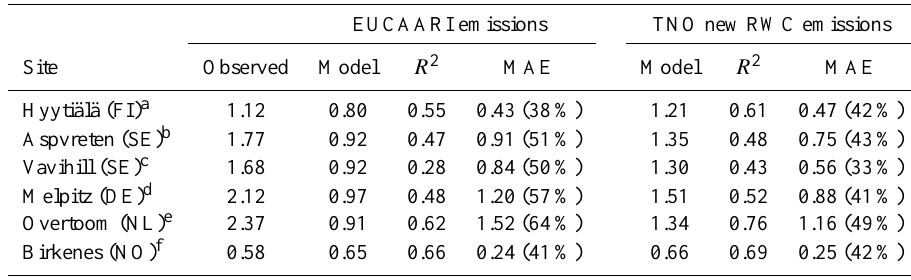
Figure 8. Comparison of predicted (PMCAMx) vs. observed (AMS) PM 1 OA (µgm − 3 ) from seven measurement sites during the EUCAARI winter 2009 campaign (25 February–23 March). Each point is a daily average value. The dashed lines represent 2:1 and 1:2 lines. Table 4. Evaluation of EMEP MSC-W model prediction results (with two different inventories for residential wood combustion emissions) to data from observations during the winter half-years (November–April) in 2007–2009. Observed: average measured OC concentration; Model: average modelled OC concentration (for the periods with measurements, see footnotes); R 2 : coefficient of determination; MAE: mean of absolute error. Units for Observed, Model and MAE: µg ( C ) m − 3 . The relative MAE = MAE/Observed is given in parentheses (in